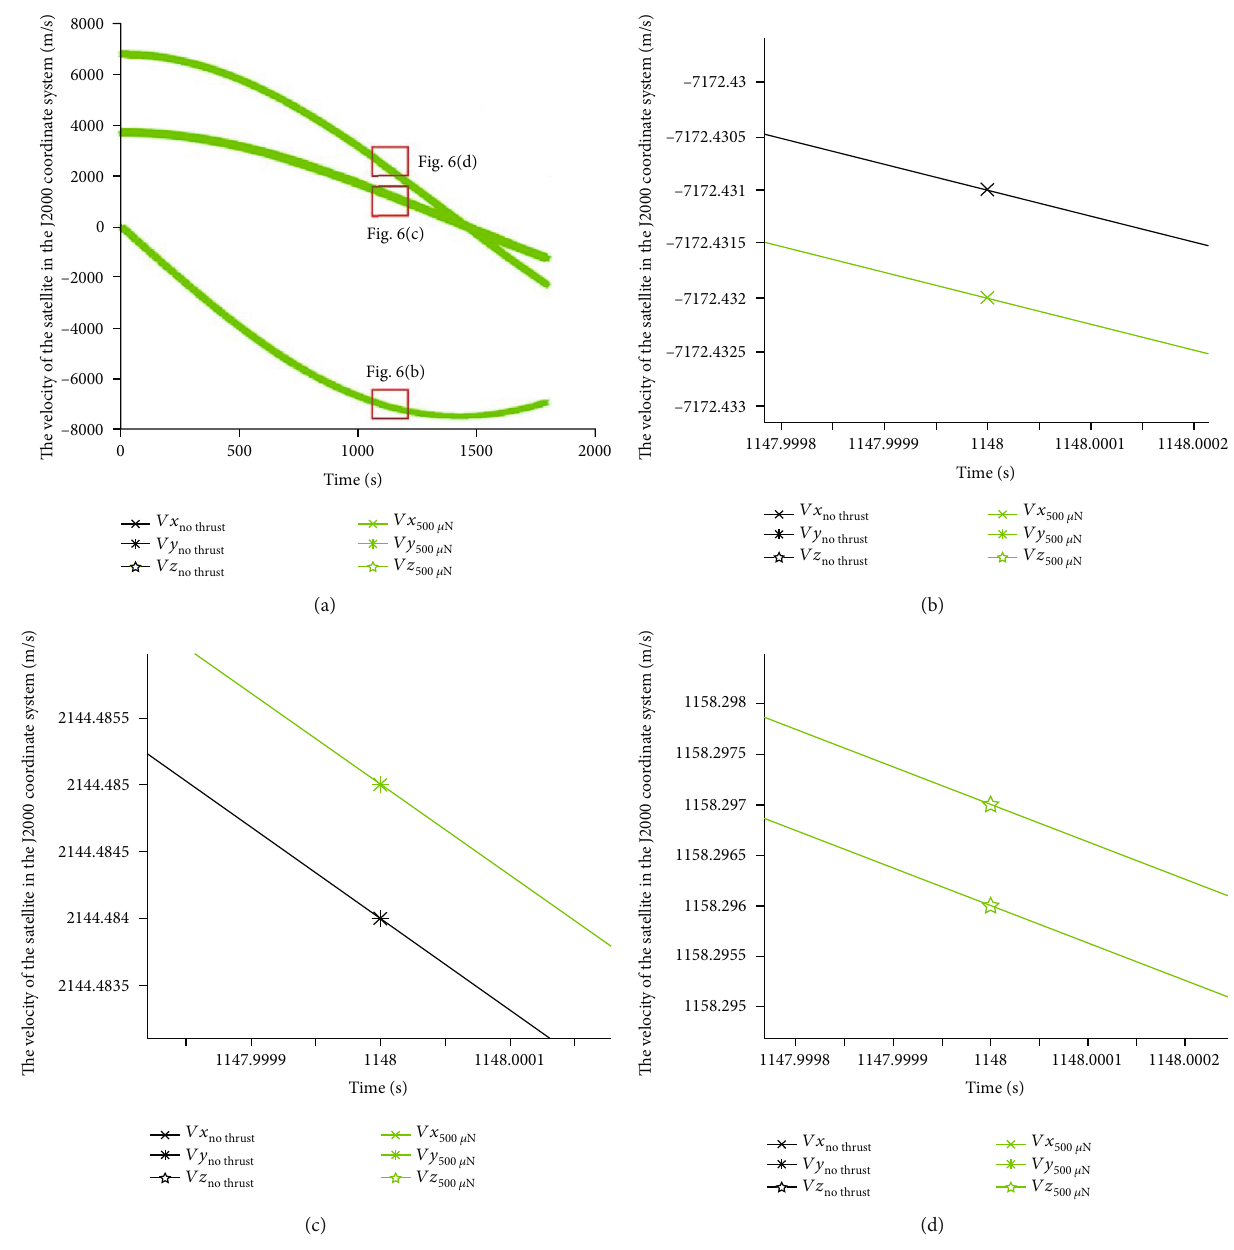
Figure 5: Velocity of the satellite under the action of 500 μ N